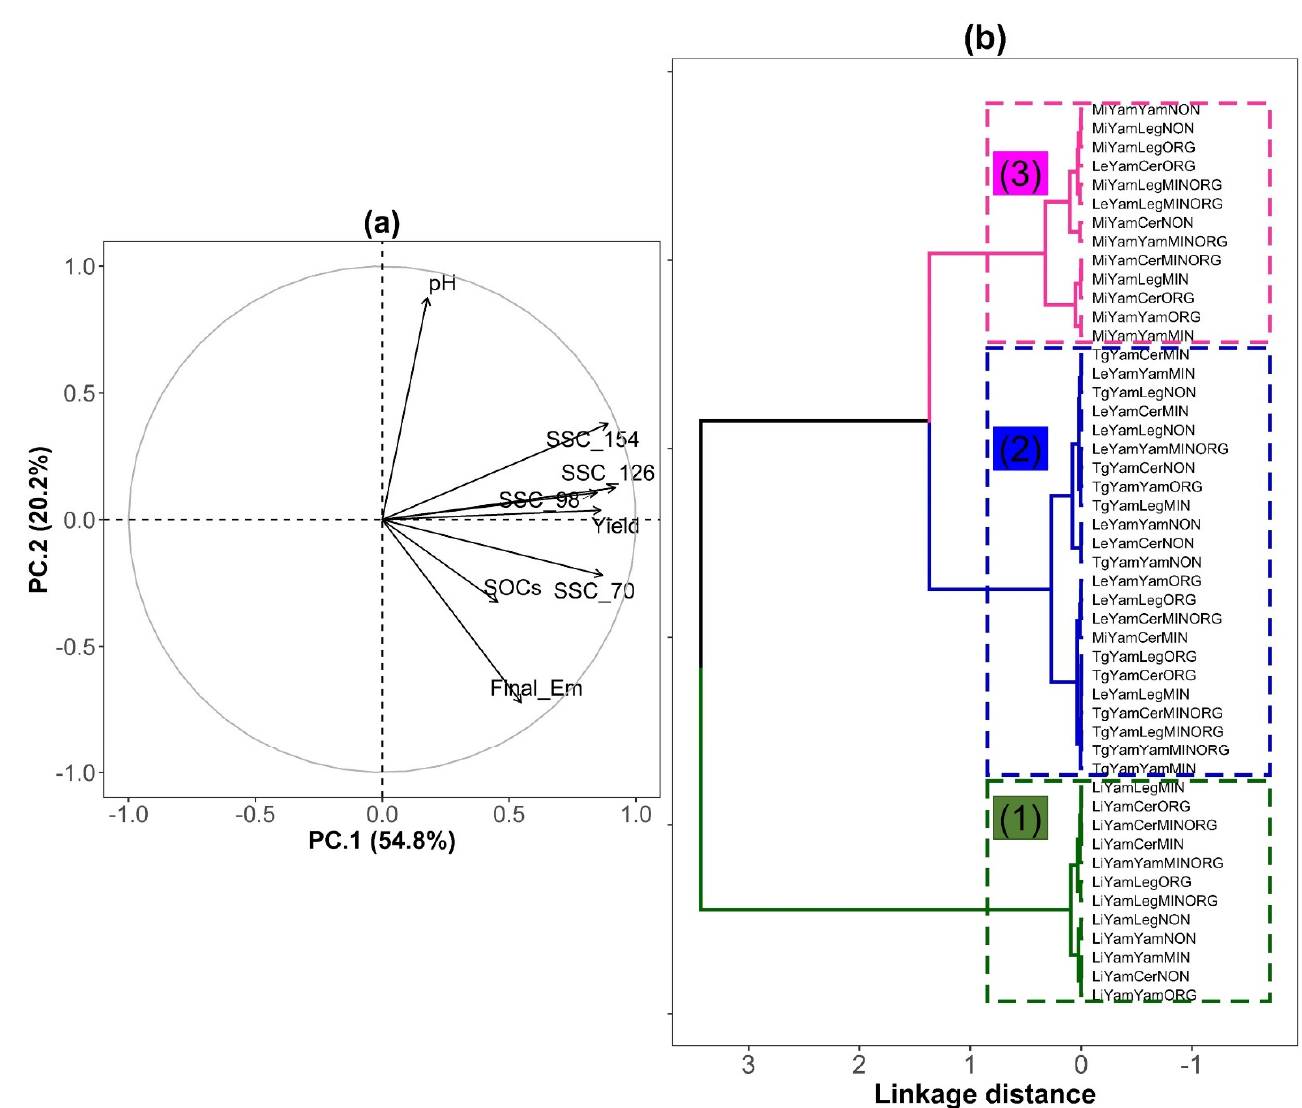
Figure 7. Normalized principal component analysis (PCA) and hierarchical clustering of principal components (HCPC) on soil carbon stocks and pH measured in December 2017, and water yam growth and yield in Liliyo and Tiéningboué (Côte d’Ivoire), and Midebdo and Léo (Burkina Faso), under various fertilization regimes in 2018: ( a ) correlation circle, ( b ) dendrogram of hierarchical clustering based on the Ward’s criterion. The yam variety C18 was cultivated in the four sites after either a cereal (YamCer), a legume (YamLeg), or a white yam (YamYam) for each fertilization regime. The linkage distance of the branches indicates the dissimilarity between clusters. The fertilization regimes are: NON (no fertilization), MIN (sole mineral fertilization as NPK), MINORG combined organic and mineral fertilization), and ORG (sole organic fertilization as manure). SOCs = Soil carbon stocks; pH = pH (H 2 O); Final_EM = final sprout emergence rate; SC_70, SC_98, SC_126, and 154 = Soil surface coverage by water yam above-ground organs at 70, 98, 126, and 154 days after planting; Yield = Yam fresh tubers yields in t ha − 1 ; Li = Liliyo; Tg = Tiéningboué; Mi = Midebdo; Le = Léo.